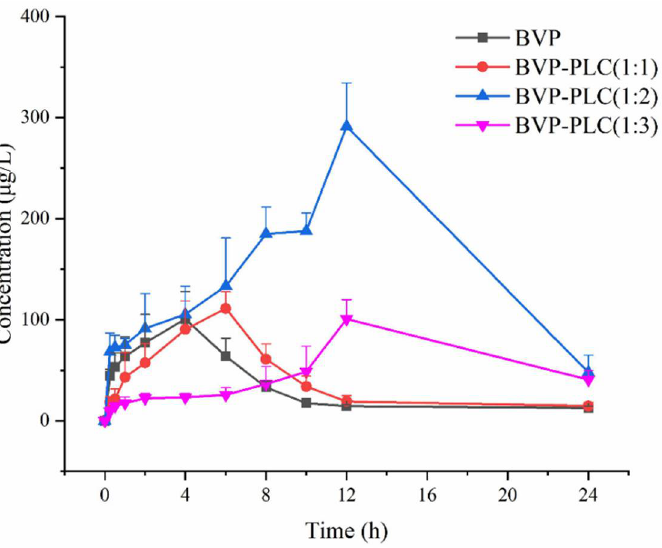
Figure 11. The plasma concentration-time curves of BVP and BVP-PLC with different drug-lipid ratios after single administration (i.g.).